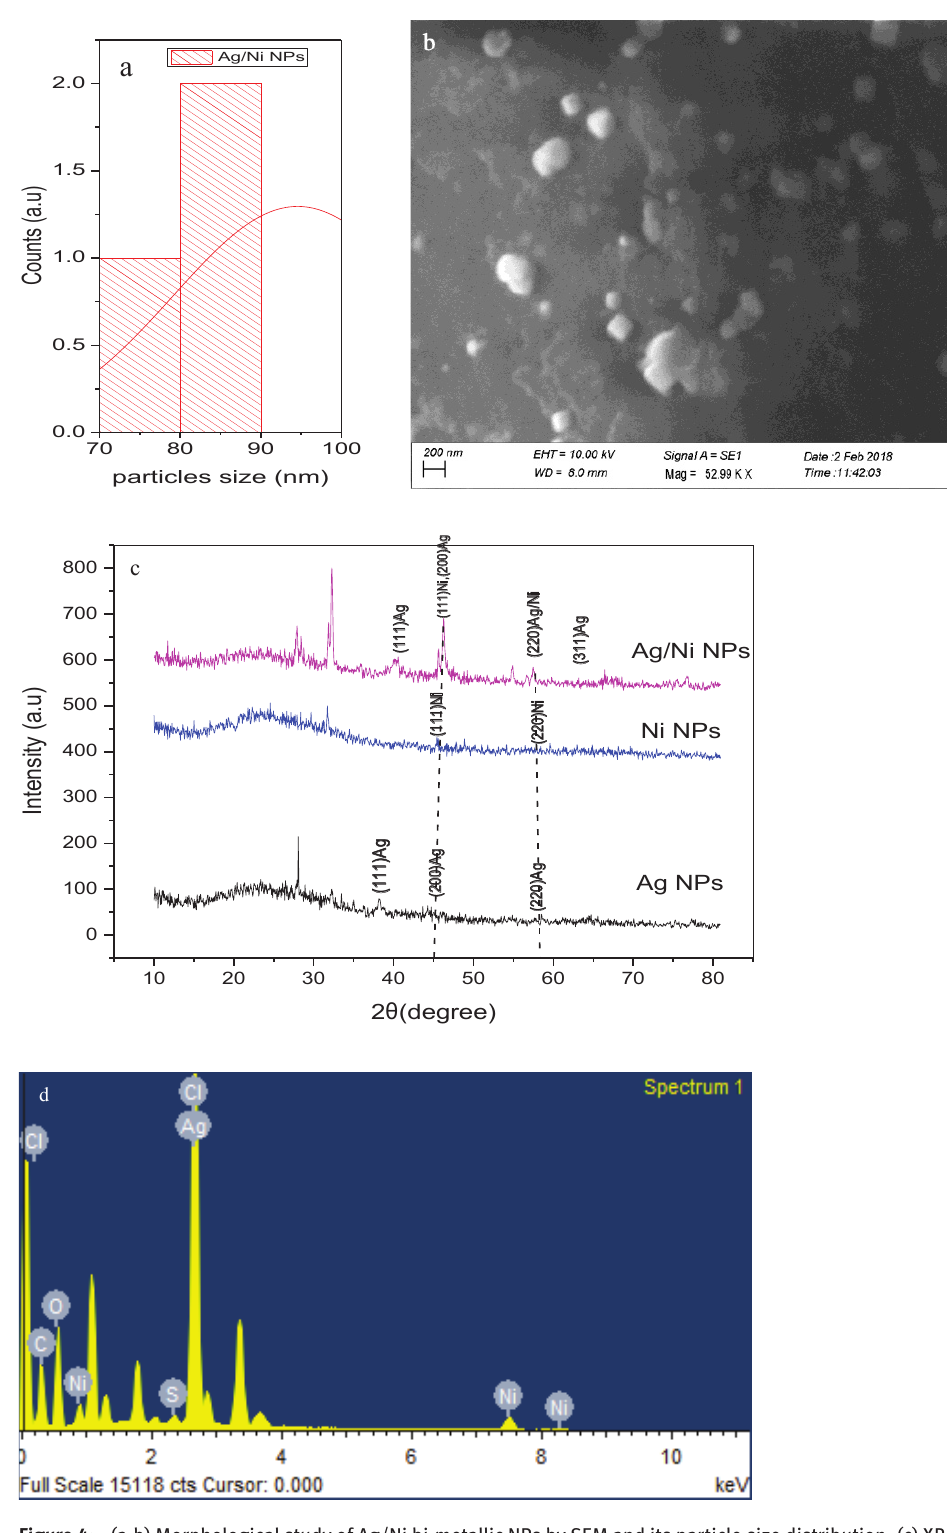
Figure 4: (a,b) Morphological study of Ag/Ni bi-metallic NPs by SEM and its particle size distribution; (c) XRD pattern of Ag/Ni bi-metallic NPs; (d) EDX spectrum of Ag/Ni bi-metallic